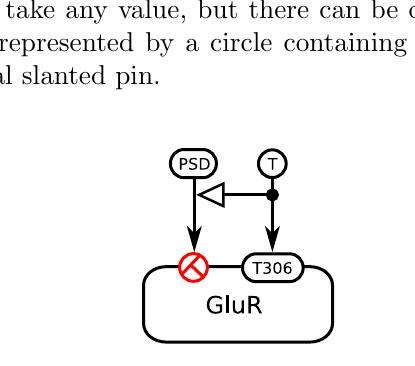
Figure 2.36: Using the state variable location to represent the fact that phosphorylation of glutamate receptors stimulate their incorporation in the post-synaptic density.